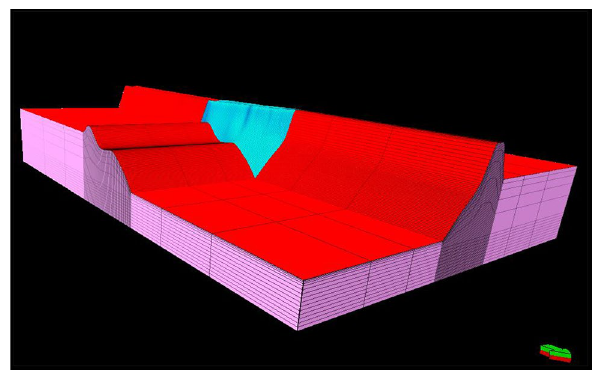
Fig. 13 Underburden geomechanical portion